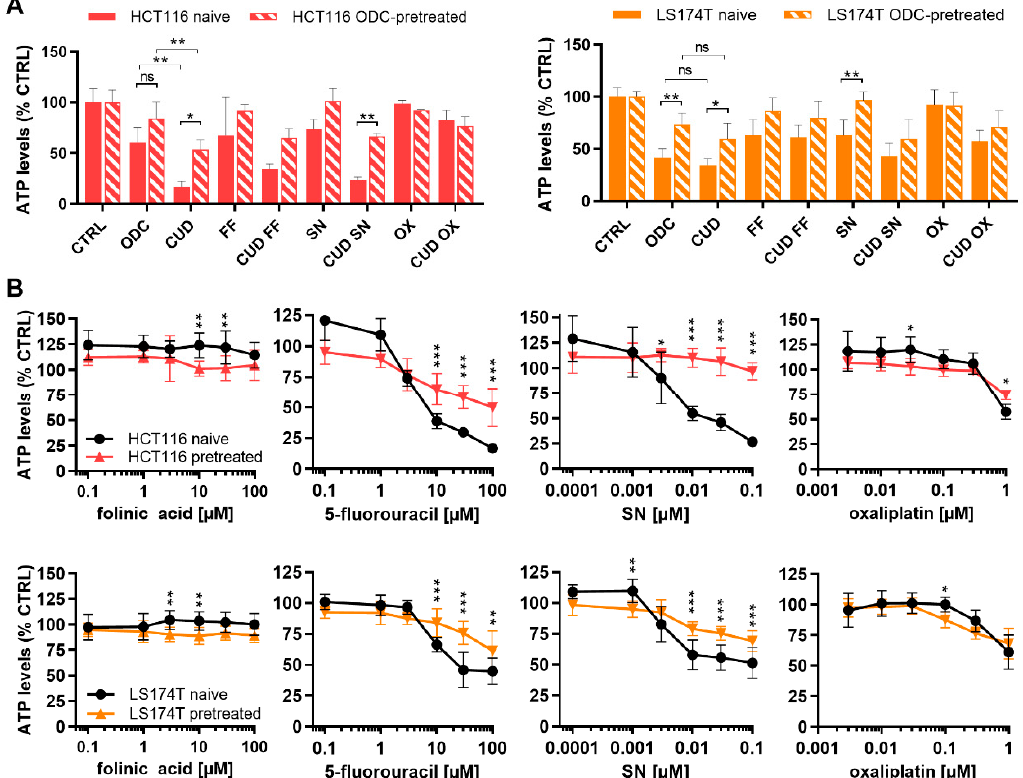
Figure 7. Drug combination activity in chronically ODC-pretreated cells. ( A ) Drug combination efficacy of the ODC and CUD on cell metabolic activity in HCT116 and LS174T naïve and FA/5-FU/SN/OX pretreated cells (HCT116-pretreated and LS174T-pretreated). ( B ) Drug dose-response curves of folinic acid (FA), 5-fluorouracil (5-FU), SN and oxaliplatin (OX) in HCT116 and LS174T naïve and FA/5-FU/SN/OX pretreated cells. Drug concentrations are presented on a logarithmic scale. Error bars represent the SD and significances of * p < 0.05, ** p < 0.01 and *** p < 0.001 represent the comparison between naïve and pretreated cells (unpaired t-test) or the comparison between the ODC and CUD (two-way ANOVA with post-hoc Dunnett’s or Sidak’s multiple comparisons test) including ( A ) N = 3 or ( B ) N = 3–4, respectively.